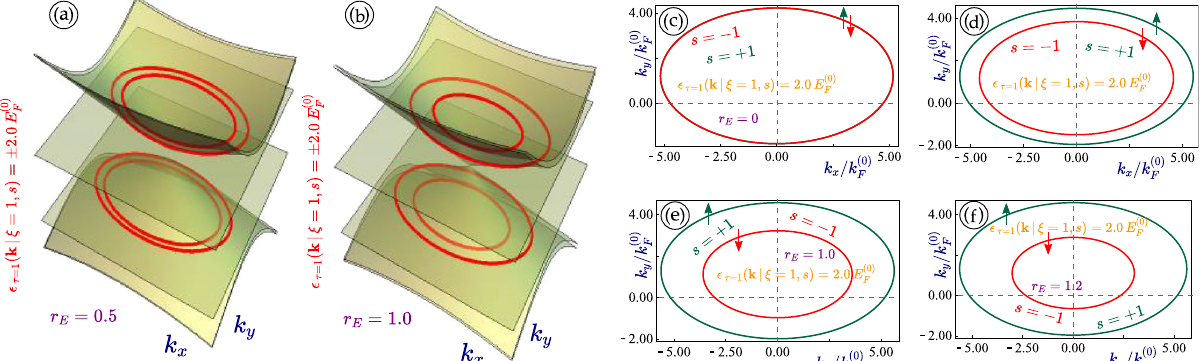
Figure 2. (Color online) k y -dependence of the energy dispersions ε τ ( k x -MoS 2 . Each panel corresponds to a different value of the perpendicular electric fields r E 1.2, where the smaller band gap of spin s considered cases.